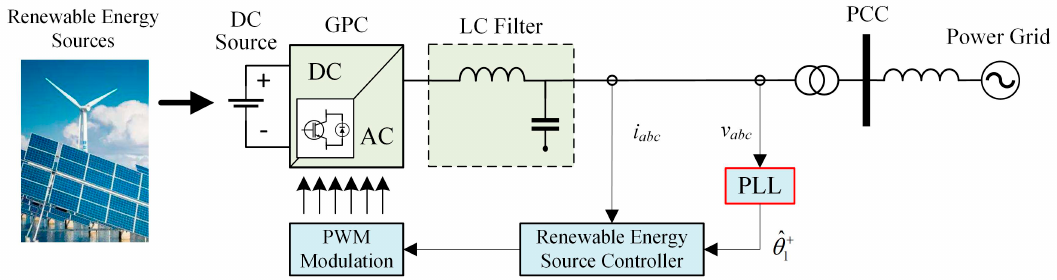
Figure 2. Block schematic of a typical grid-connected power converter system.